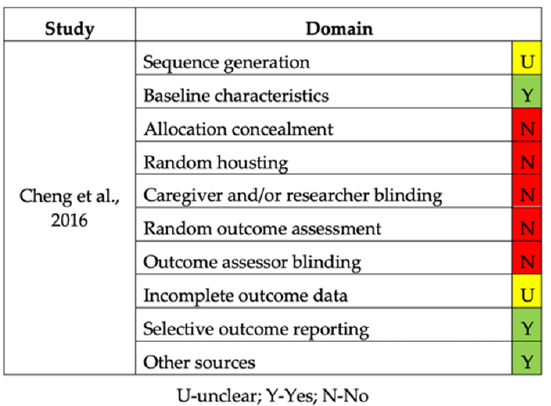
Figure 2. Risk of bias of the in vitro studies.